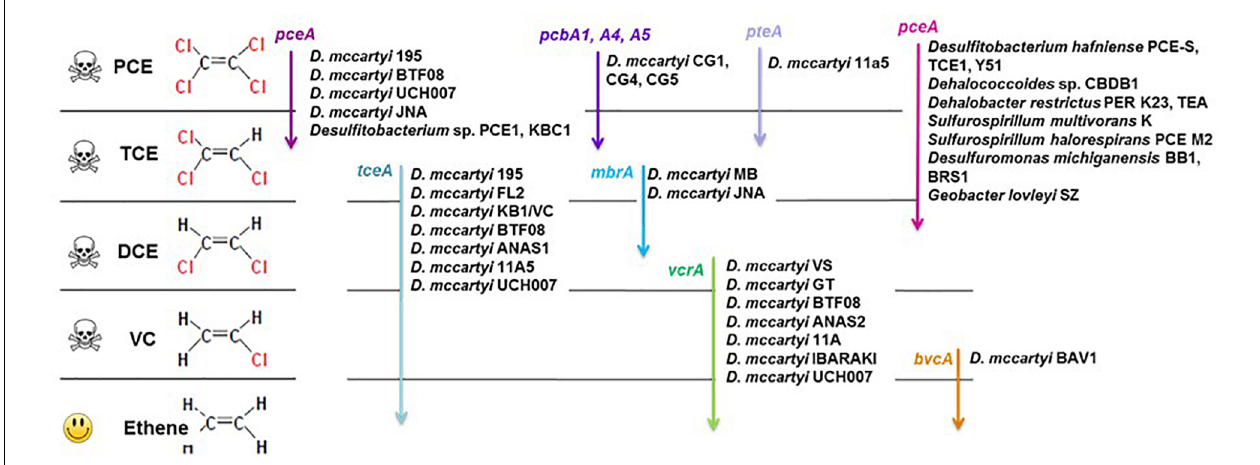
FIGURE 1 | Organohalide respiration pathways of chloroethenes, associated bacteria and reductive dehalogenase genes (based on Futagami et al., 2008; Hug, 2016; Zhao et al., 2017; Saiyari et al.,